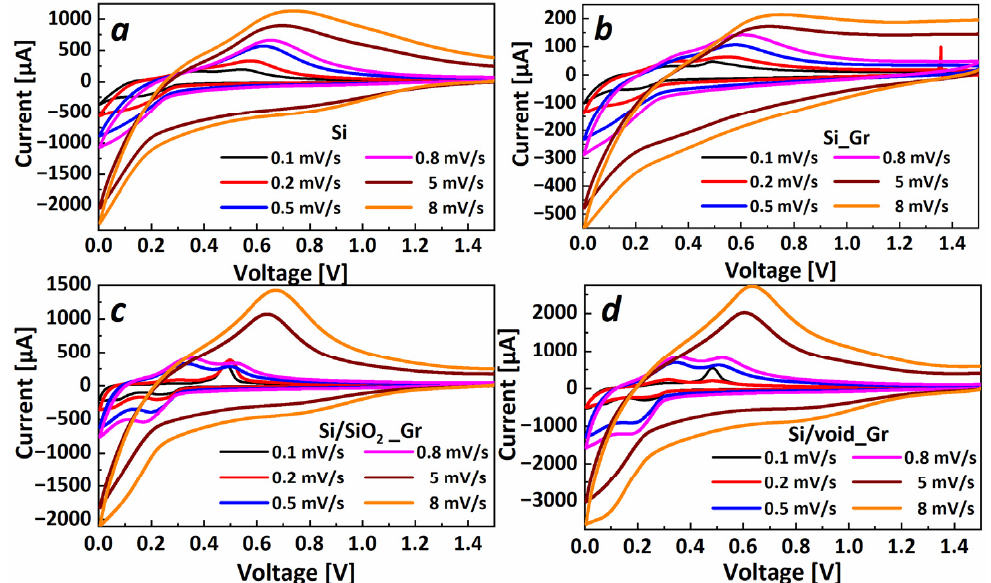
Figure 5. Cyclic Voltammetry from 5th to 10th cycles at 0.1 mV/s, 0.2 mV/s, 0.5 mV/s, 0.8 mV/s, 5 mV/s, and 8 mV/s scan rates, respectively, for ( a ) Si nps, ( b ) Si_Gr, ( c ) Si/SiO 2 _Gr, and ( d ) Si/void_Gr.